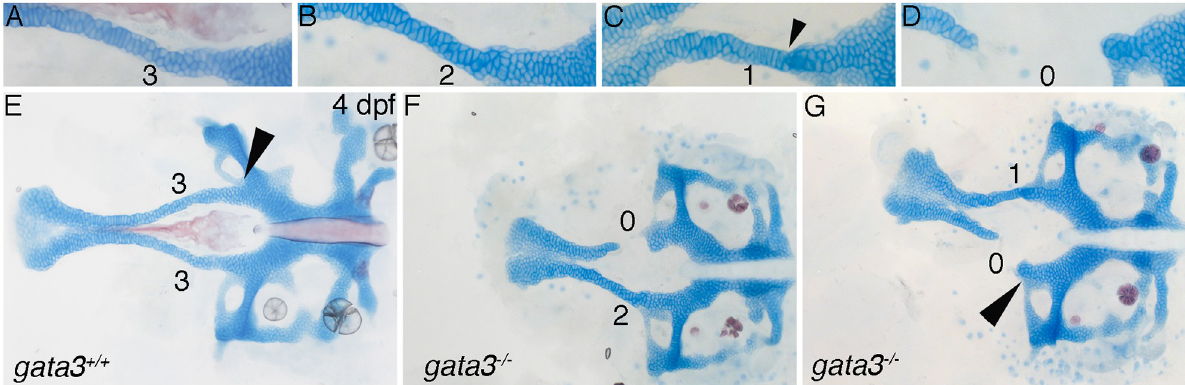
Fig 2. Quantitative scoring of gata3 mutant phenotypes. (A-G) Flat mounts of 4 dpf neurocrania, anterior to the left showing magnified images of trabeculae. Phenotypes were scored on individual sides of the neurocranium according to the level of disruption to the trabeculae. (A) Wild type phenotype (score = 3) with trabeculae fused and in one plane with the posterior neurocranium. The cells within the trabeculae are arranged into a column resembling a stack of coins. (B) Disruption to the columnar arrangement of trabeculae cells (score = 2) with proper fusion to the posterior neurocranium with all cells in one plane. (C) Trabeculae cells not stacked properly and fused inappropriately, below the plane of the posterior neurocranium, see arrowhead (score = 1). (D) Loss of trabeculae cells (score = 0) and therefore no fusion to the posterior neurocranium. (E-G) 4 dpf flat mounted neurocrania, anterior to the left showing examples of trabeculae scoring. (E) Wild type zebrafish with arrowhead indicating proper lateral commissure fusion. (F-G) gata3 mutant embryos, arrowhead in G indicating improper lateral commissure fusion. In subsequent figures the numbering above the trabeculae reflect trabeculae